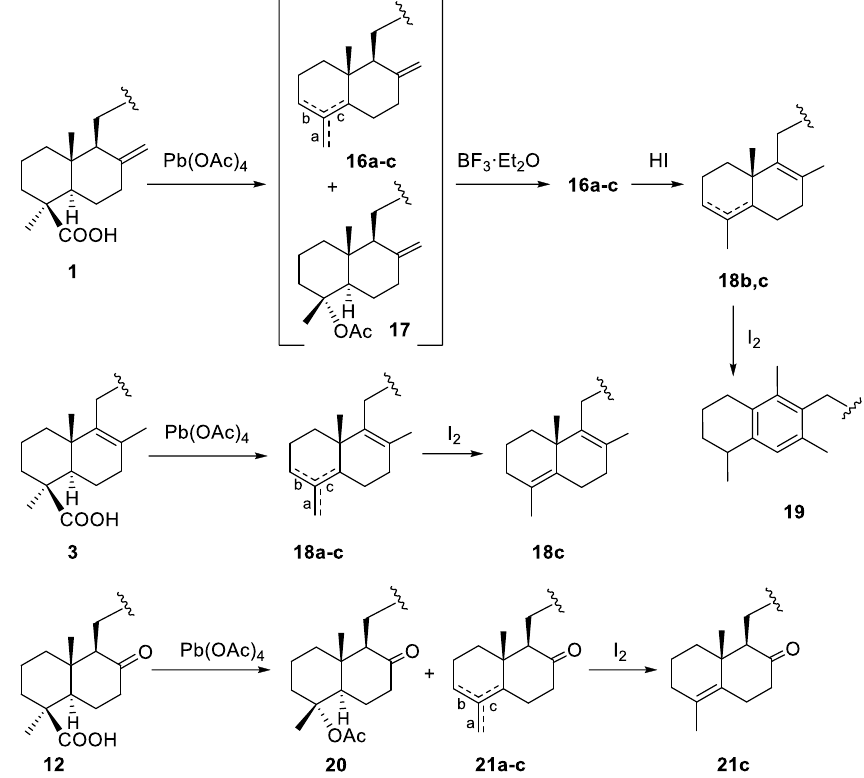
Scheme 6. Decarboxylations and further reactions of DTHQs 1 , 3 and 12